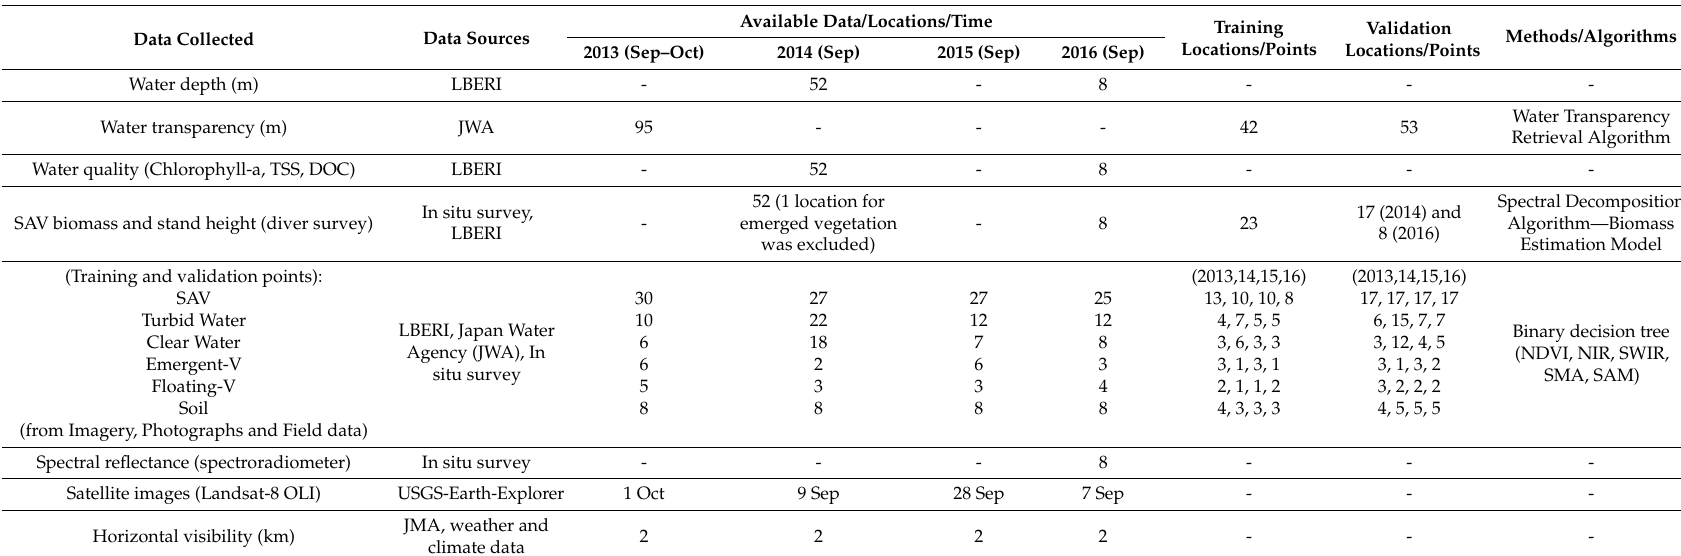
Table 1. Available data information for the south basin of Lake Biwa